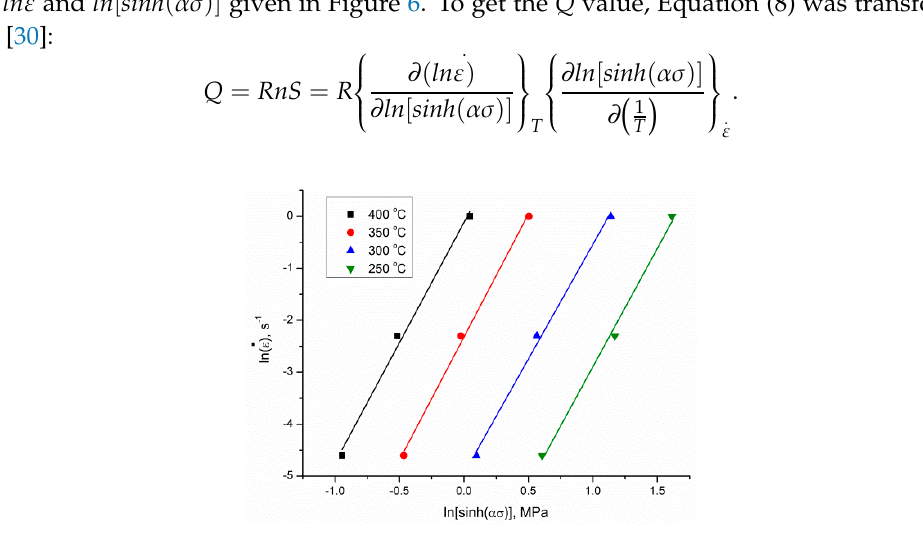
Figure 6. The relationship between ln( 𝜀(cid:4662) ) and ln[𝑠𝑖𝑛ℎ(𝛼𝜎)] .